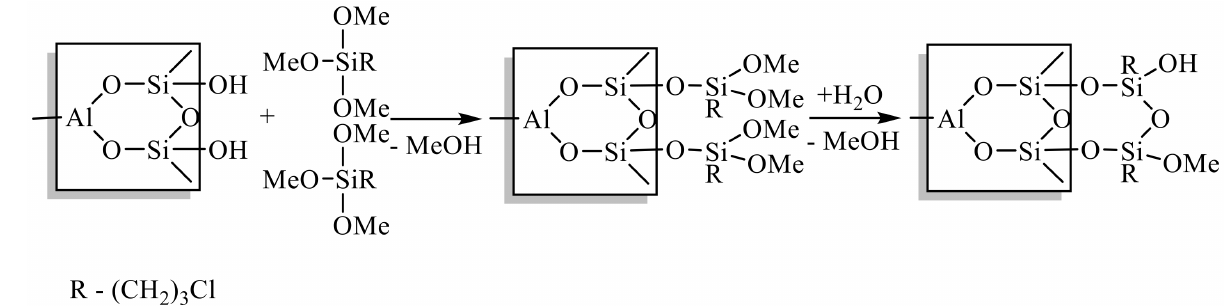
Figure 1. The synthetic route that was used during the grafting of CPTMS onto the HNT